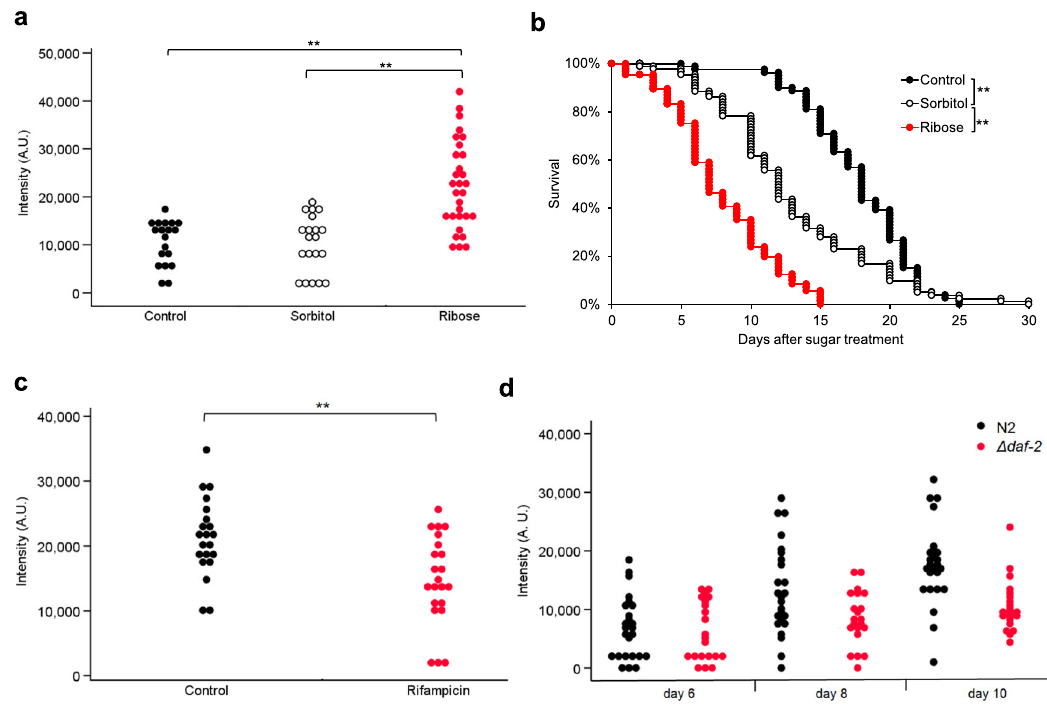
Fig. 4 Effects of AGEs-accelerating sugar, an AGEs blocker, and the lifespan-extending mutation daf-2 on blue fl uorescence in individual worms. a Auto fl uorescence (ex 340/em 430) of individual worms (wild-type N2) that were incubated for 4 days on mNGM containing 400 mM ribose ( n = 30) or 400 mM sorbitol ( n = 20) to match the osmolality of high ribose; the number of control worms was 19. The auto fl uorescence values were compared using the nonparametric Steel – Dwass method (** p < 0.01). b Survival curve of worms (wild-type N2) grown in the presence of supplemental ribose ( n = 74); the numbers of worms provided as the control and those cultured with sorbitol were 79 and 84, respectively. Worms were 3 days old on Day 0. Nematode survival was calculated by the Kaplan – Meier method, and the statistical signi fi cance of differences was tested by the log-rank test (** p < 0.01). c Auto fl uorescence (ex 340/em 430) in worms (wild-type N2) grown in the presence of rifampicin ( n = 22), an AGEs blocker, or DMSO as the solvent control ( n = 21). The auto fl uorescence values were compared using Student ’